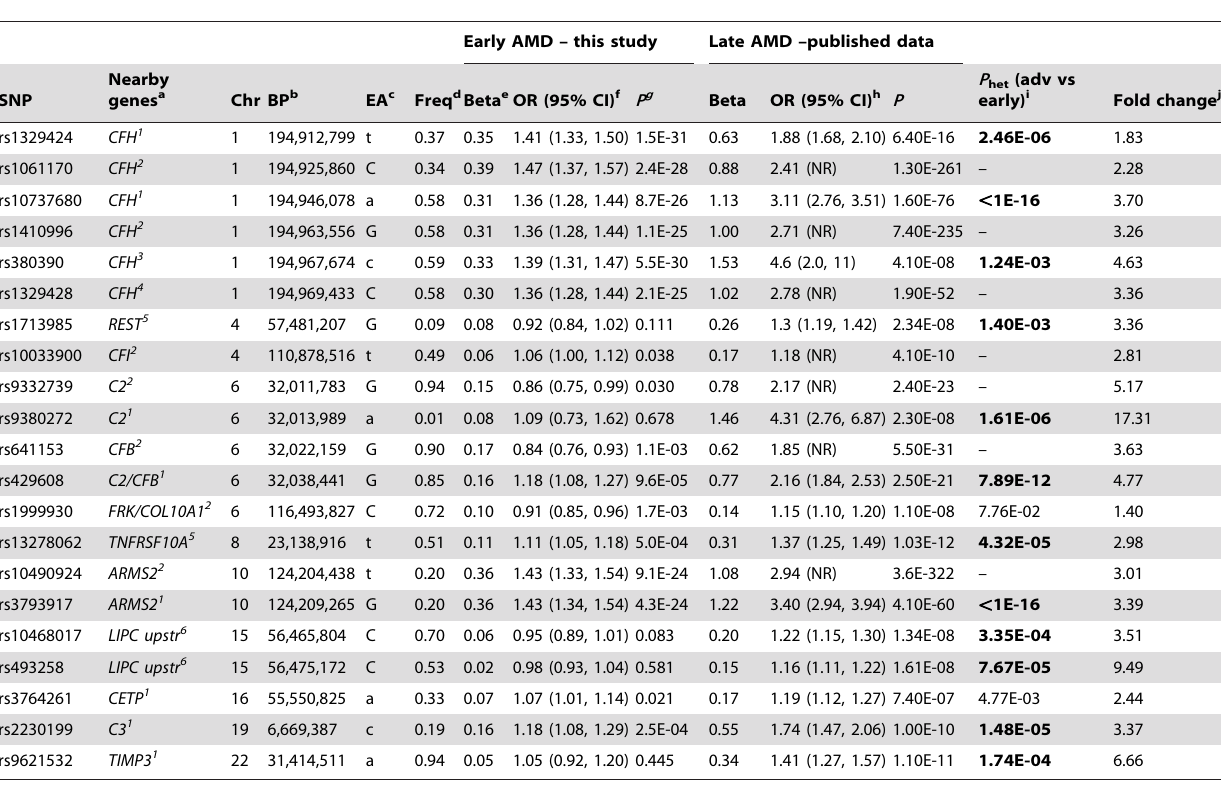
Table 4. Comparison of effect sizes for early AMD from this study versus published effect estimates for late